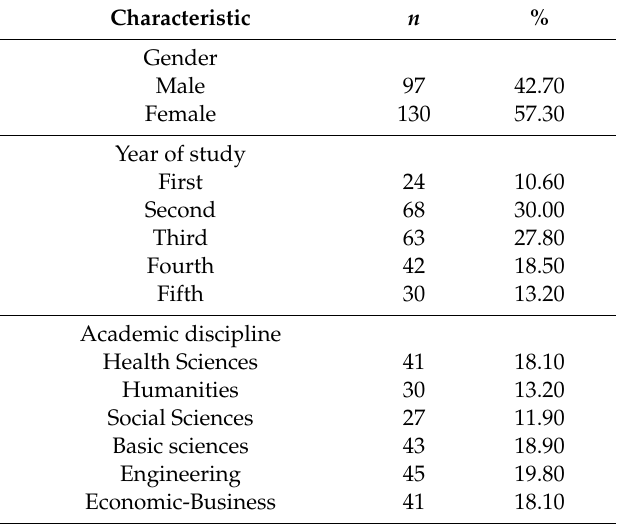
Table 2. Sociodemographic characteristics of participants ( n =